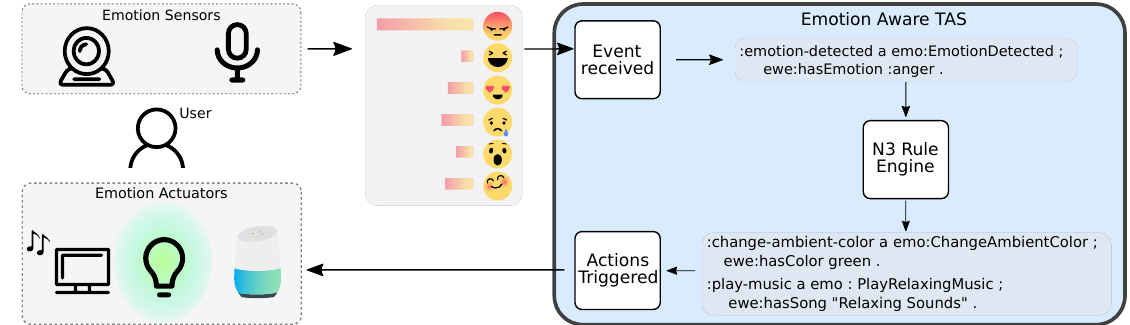
Figure 3. Deployment for the